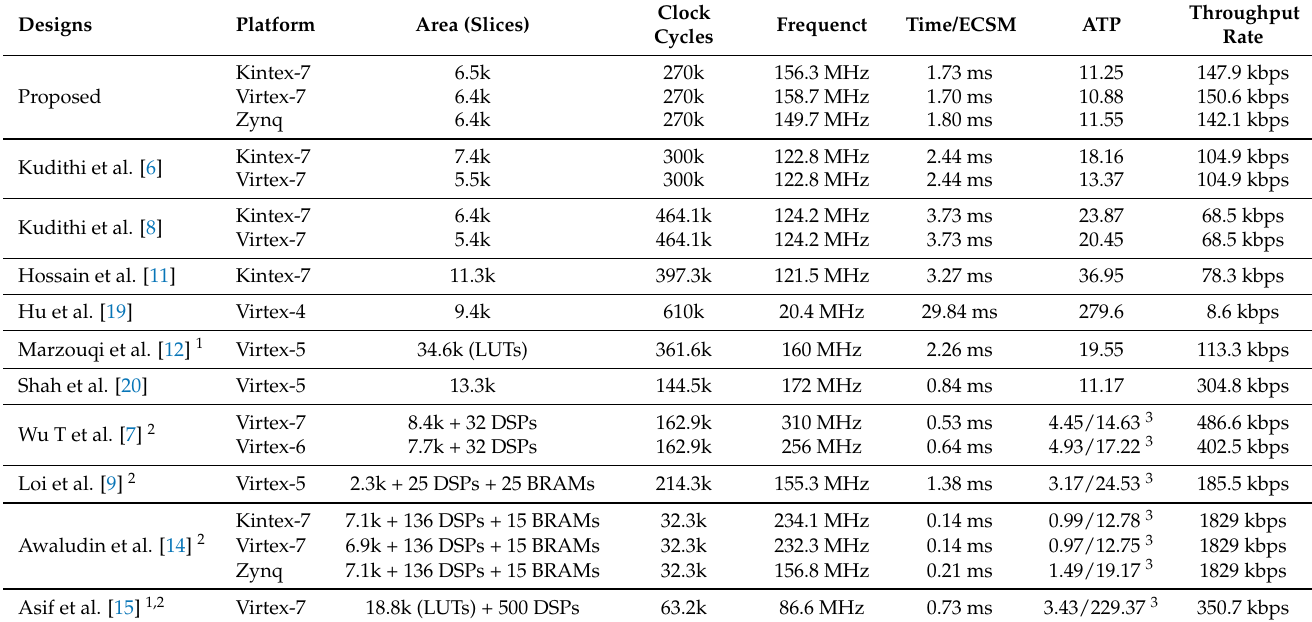
Table 6. Performance comparison of several ECSM architectures for Weierstrass curve up to 256-bit field